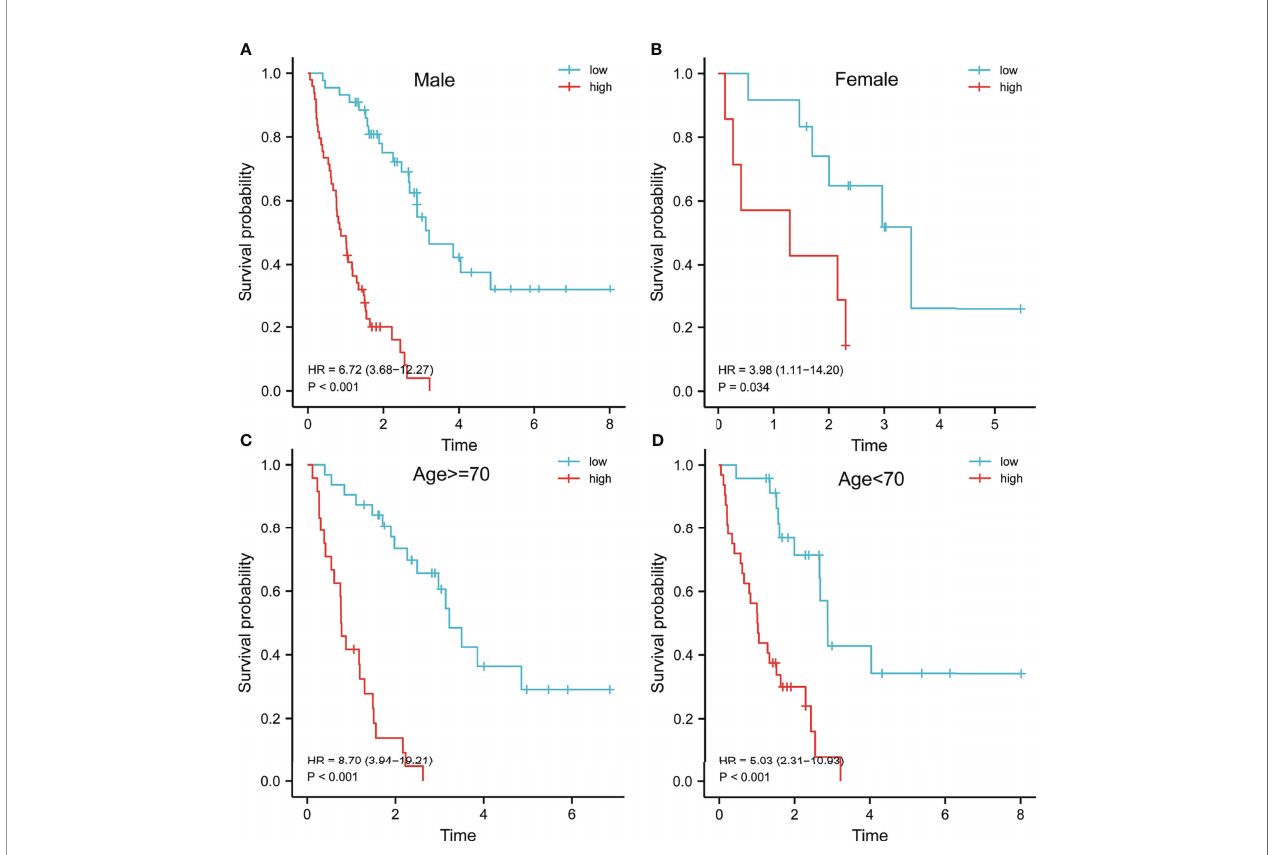
FIGURE 6 | Survival analysis of patients with idiopathic pulmonary fi brosis in different subgroups. Kaplan – Meier survival analysis of the risk model in different subgroups, including male (A) , female (B) , age > = 70 years (C) and age < 70 years (D)